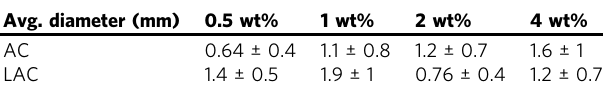
Table 2 Average diameters of DCPD/AC and DCPD/LAC foams, and their standard deviation values from three replicates are